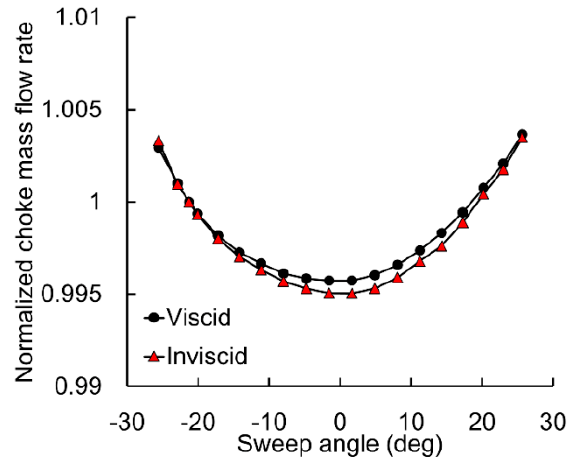
Figure 9. Choke mass flow rate of cases with different sweep angle.